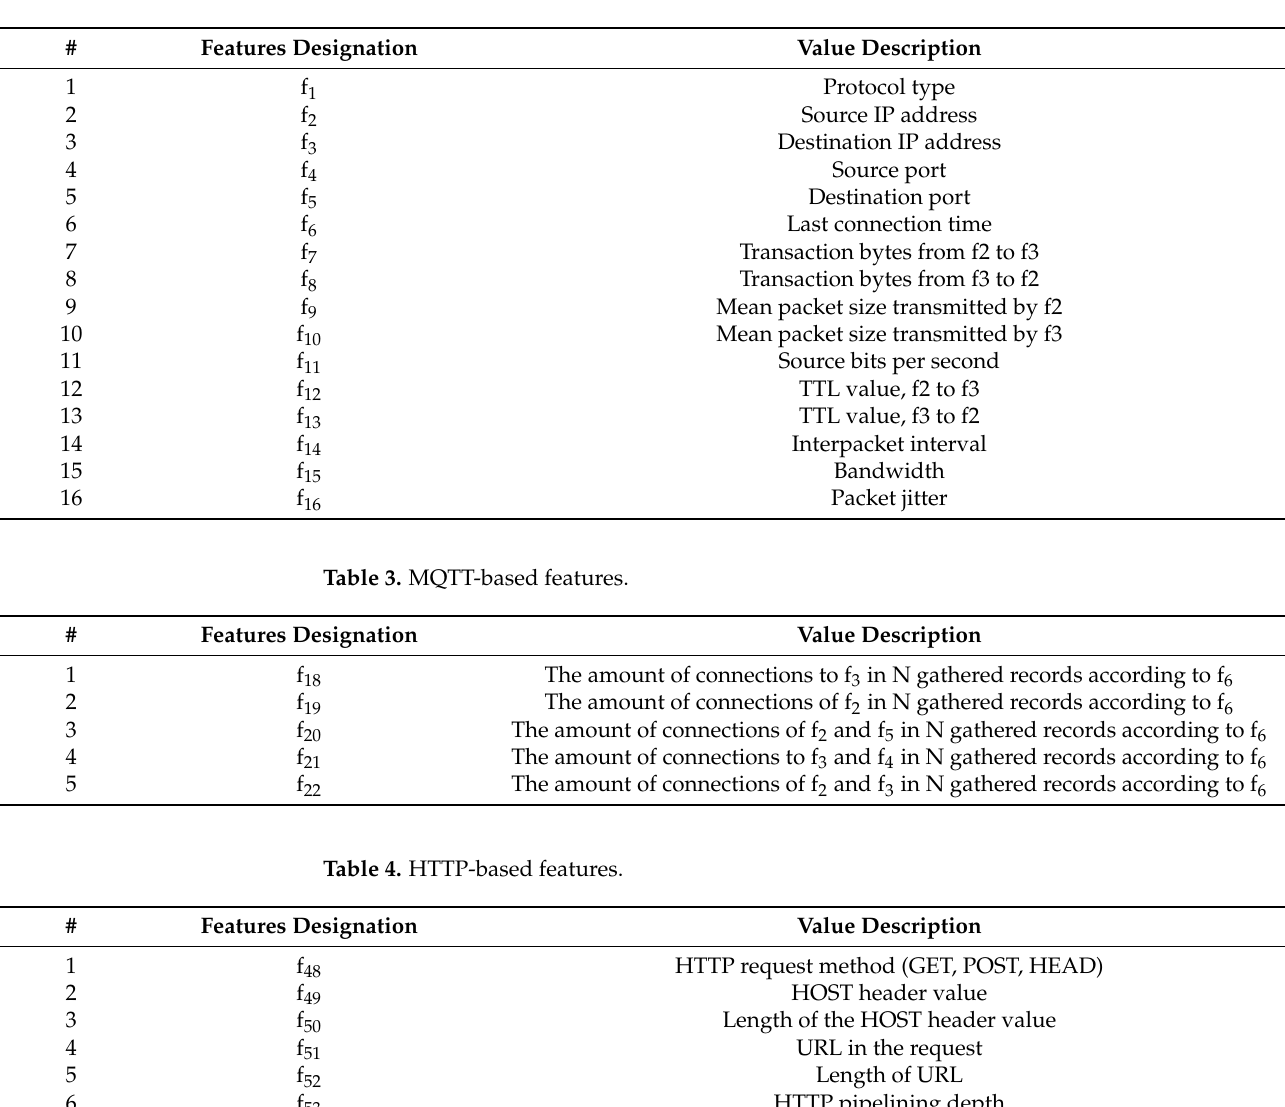
Table 2. Flow-based features.